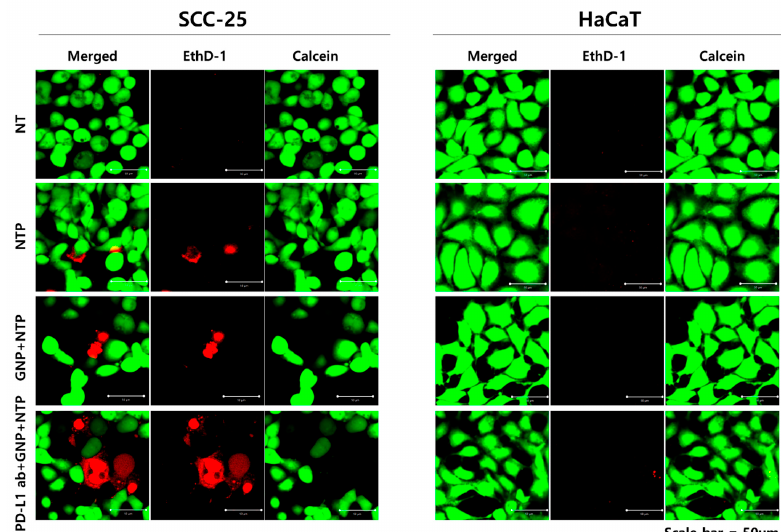
Figure 5. Comparison of the cell viability of SCC-25 and HaCaT cells following treatments using the LIVE/DEAD™ Viability/Cytotoxicity Kit. Green, live cells; red, dead cells. Compared to HaCaT cells, more dead cells were identified in SCC-25 cells among the experimental groups. Abbreviations: NT, nontreatment; ab, antibody; GNP, gold nanoparticle; NTP, nonthermal plasma. Appl. Sci. 2021 , 11 , x FOR PEER REVIEW